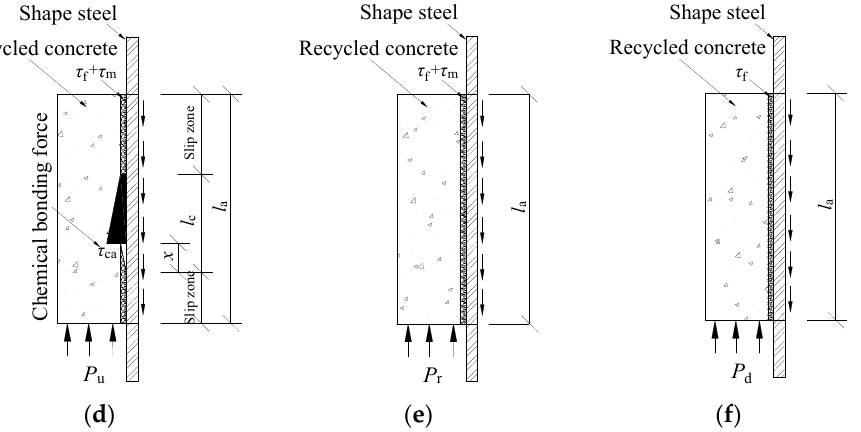
Figure 12. Diagram of specimen under different critical states, they should be listed as: ( a ) No damage stage; ( b ) Stress development state; ( c ) A state; ( d ) B state; ( e ) C state; ( f ) D state.